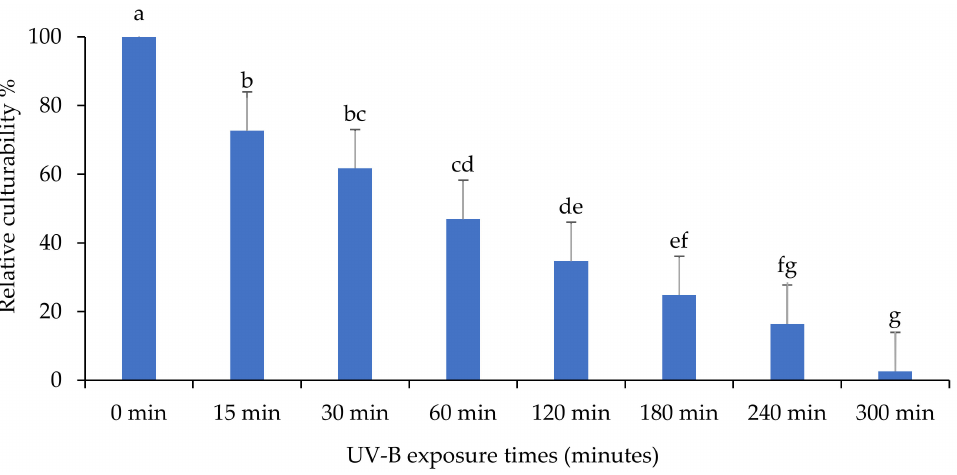
Figure 6. The impact of different UV-B exposure times on relative culturability percentage of Metarhizium anisopliae isolate “MaIDN-1”. The mean number of relative culturability percentage ± SE is shown. Different letters on the same patterned bars indicate significant differences (LSD test, p < 0.05).